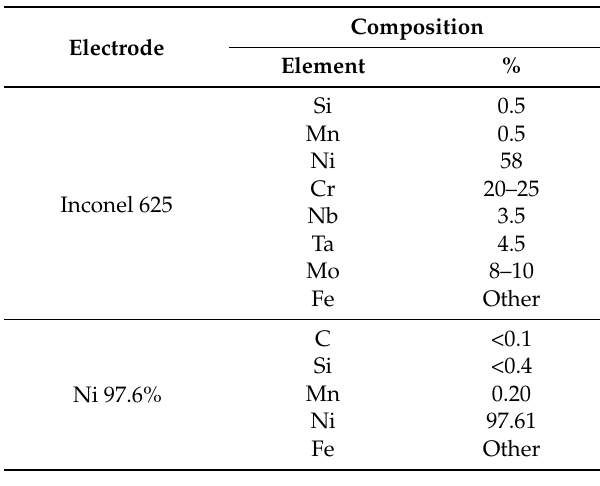
Table 3. Electrodes used for ductile iron